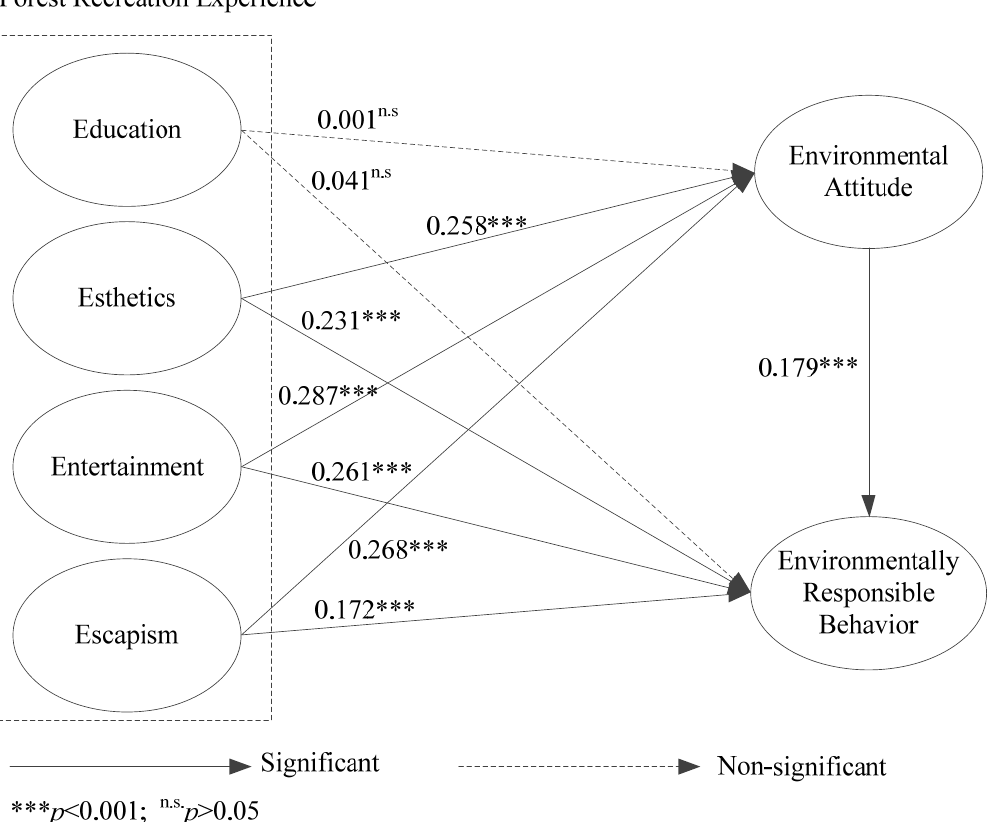
Figure 3. Standardization path coefficient and hypothesis testing results.